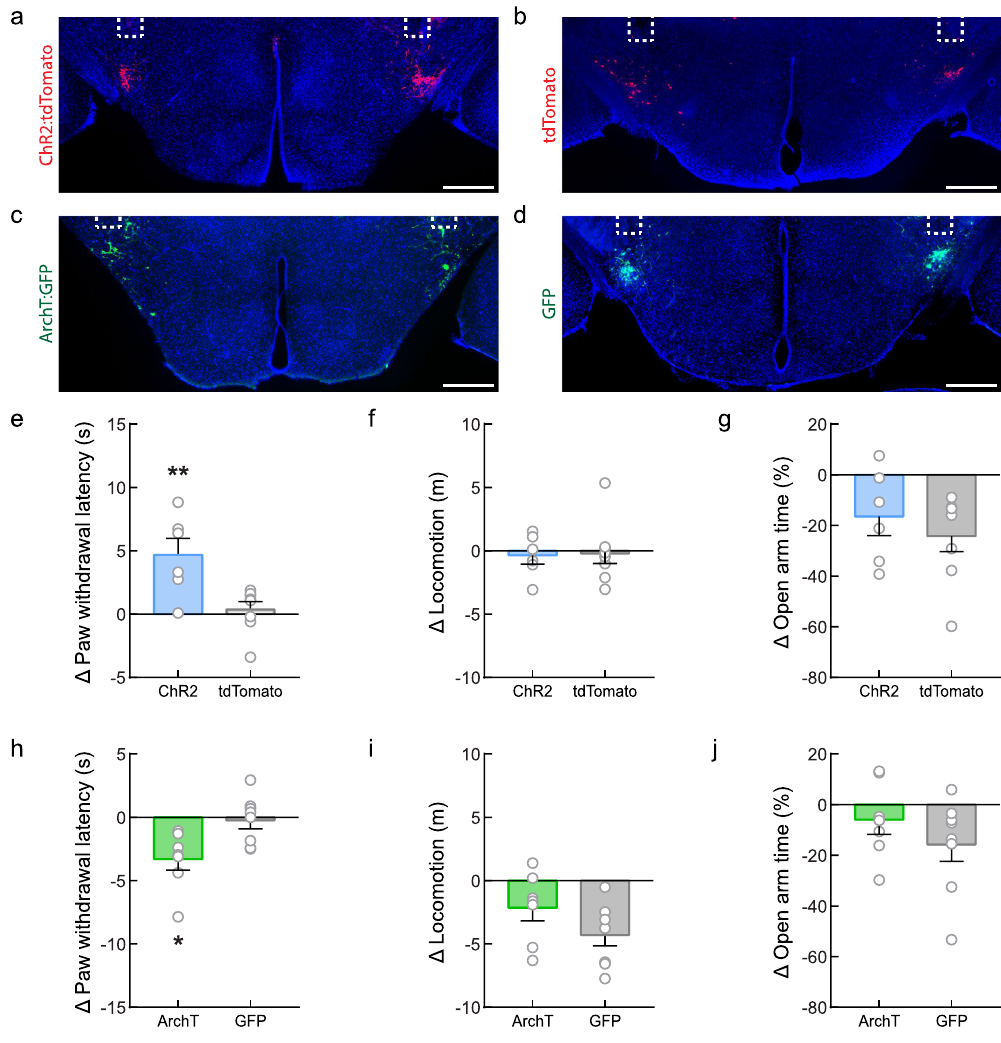
Figure 1. Bidirectional modulation of nociceptive behaviors by LH PV neurons. ( a , b ) Representative images showing bilateral expression of ( a ) ChR2:tdTomato (red) and ( b ) tdTomato (control; red) in LH PV neurons. ( c , d ) Representative images depicting ( c ) ArchT:GFP (green) and ( d ) GFP (control; green) expression. Optical fibers were implanted above the LH bilaterally (white dotted lines). Scale bars: 500 μ m. See also Supplementary Fig. S1. ( e ) Change in paw withdrawal latency in response to a 51 °C hot plate (PWL HP ) during photostimulation (450 nm, 10–15 mW, 50 Hz, 5-ms pulses) from baseline ( ∆ PWL HP = PWL HP during photostimulation – PWL HP before photostimulation). Photostimulation of LH PV :ChR2 mice (blue) evoked a significantly greater increase in PWL HP compared to control LH PV :tdTomato (gray) mice; ** p = 0.007. ( f ) Photostimulation did not affect open field locomotor activity ( ∆ locomotion = distance traveled during photostimulation – distance traveled before photostimulation) between groups; p = 0.84. ( g ) Photostimulation did not alter the time spent in the open arms of an elevated plus maze ( ∆ open arm time = percentage time spent in open arms during photostimulation – percentage time spent in open arms before photostimulation) in both LH PV :ChR2 and control mice; p = 0.44. ( h ) Photoinhibition (520 nm, 10–15 mW, constant 3 min) of LH PV :ArchT mice (green) evoked a significantly greater decrease in PWL HP compared to control LH PV :GFP (gray) mice; * p = 0.0145. ( i ) Photoinhibition did not alter locomotor activity in LH PV :ArchT compared to control mice; p = 0.13. ( j ) Photoinhibition did not alter the time spent in the open arms of an elevated plus maze in both LH PV :ArchT and control mice; p = 0.30. Bars represent mean ± s.e.m.; circles indicate data from individual